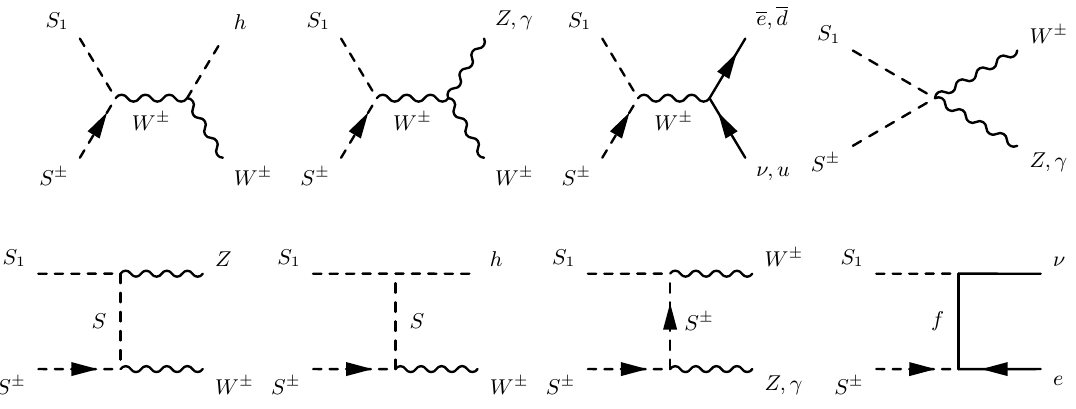
Figure 19 . Diagrams contributing to co-annihilation of S 1 with S ± .